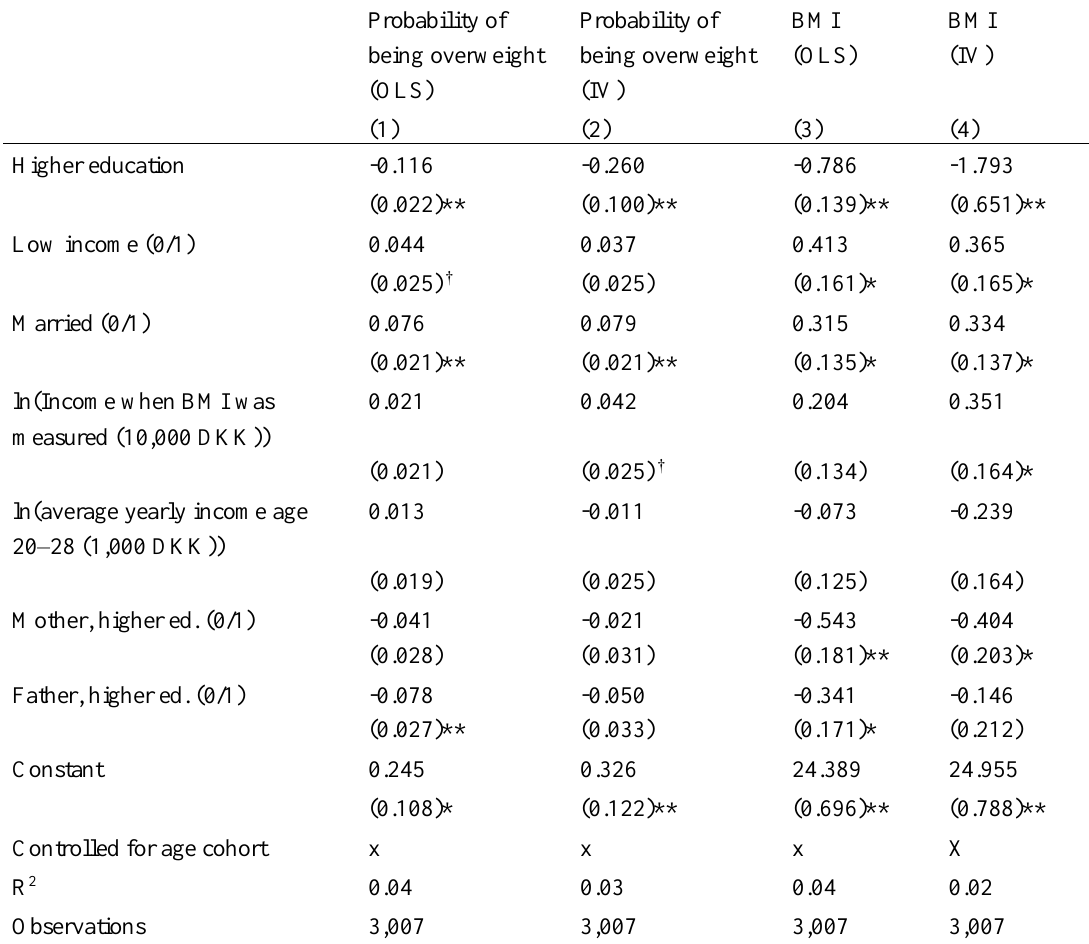
Body weight and higher education among all men. OLS and IV estimates. Parameter estimates and standard errors in